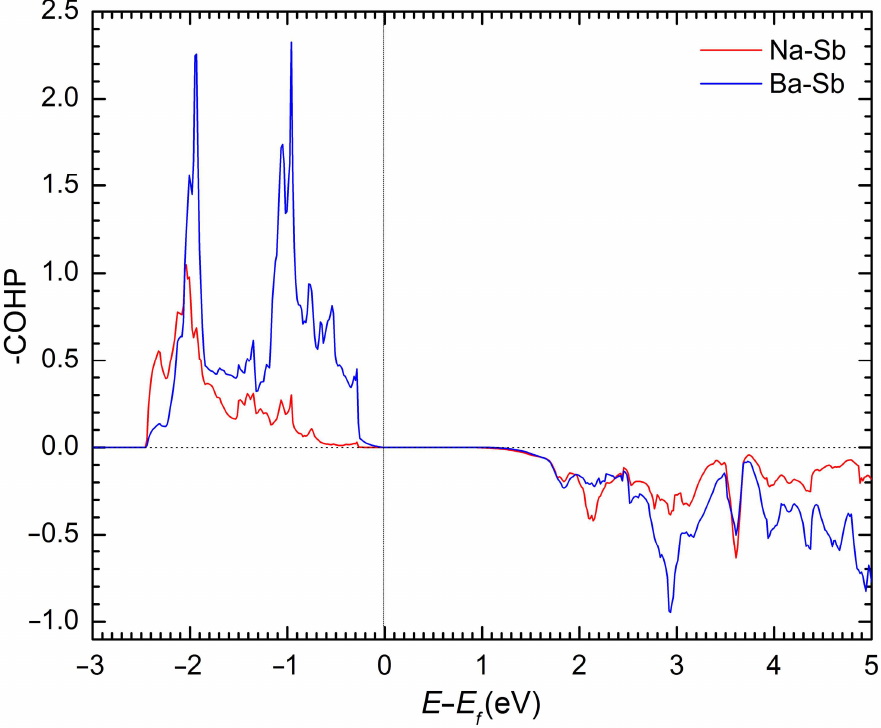
Figure 4. Crystal orbital Hamilton population curves for Na–Sb and Ba–Sb in NaBaSb.